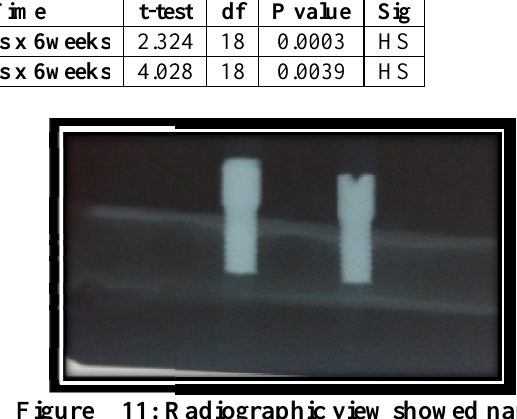
Figure 11: Radiographic view showed nano coated implant